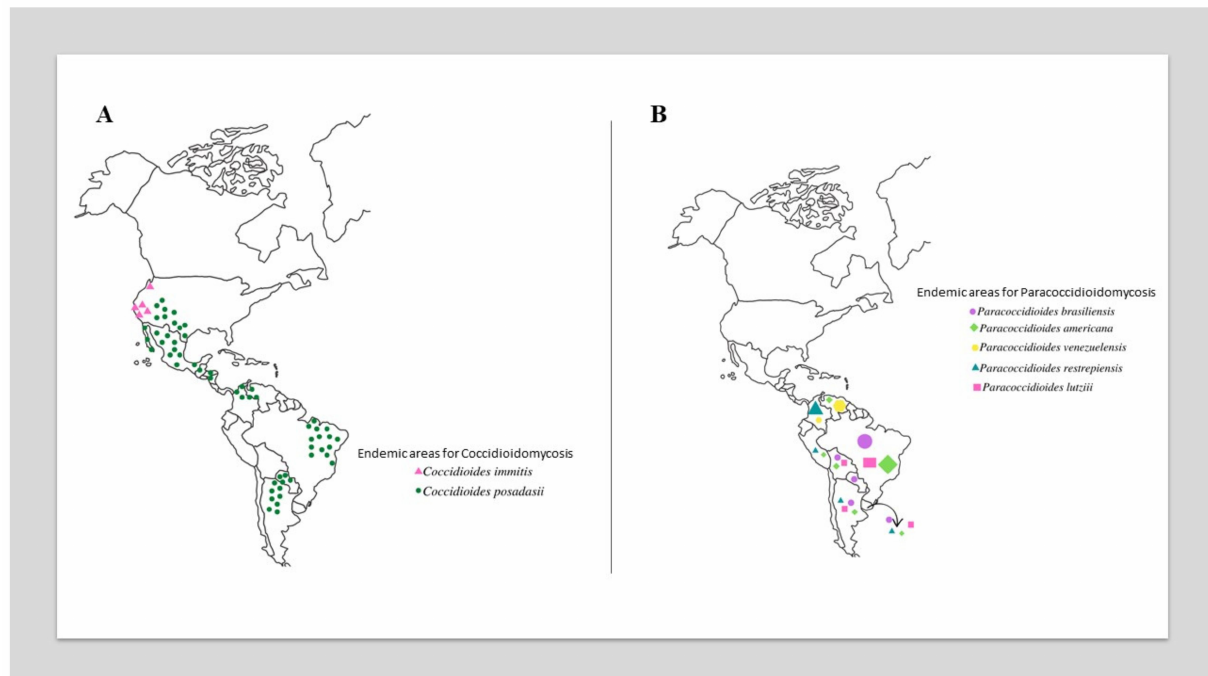
Figure 1. Global geographic distribution of Coccidioides species ( A ) and Paracoccidioides species ( B ). In Figure 1B, the size of the elements is proportional to the prevalence of species in different